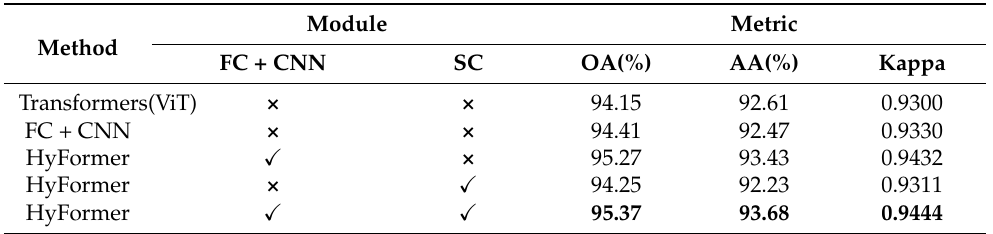
Table 4. Results of ablation experiments on the study area’s testing set using HyFormer with different module combinations.